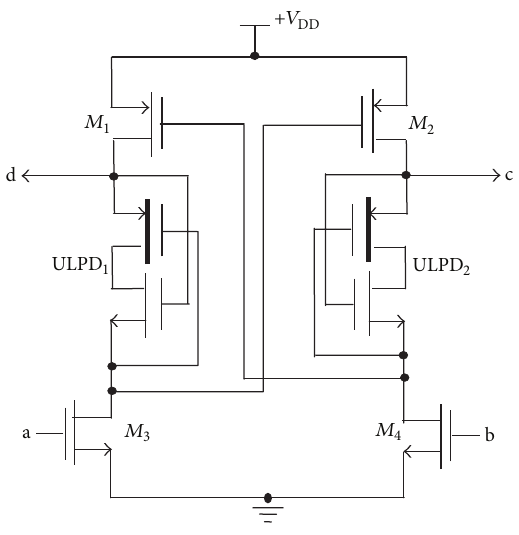
Figure 1: Conventional DCVSL-R structure. output rising from logic low to high) is higher than the